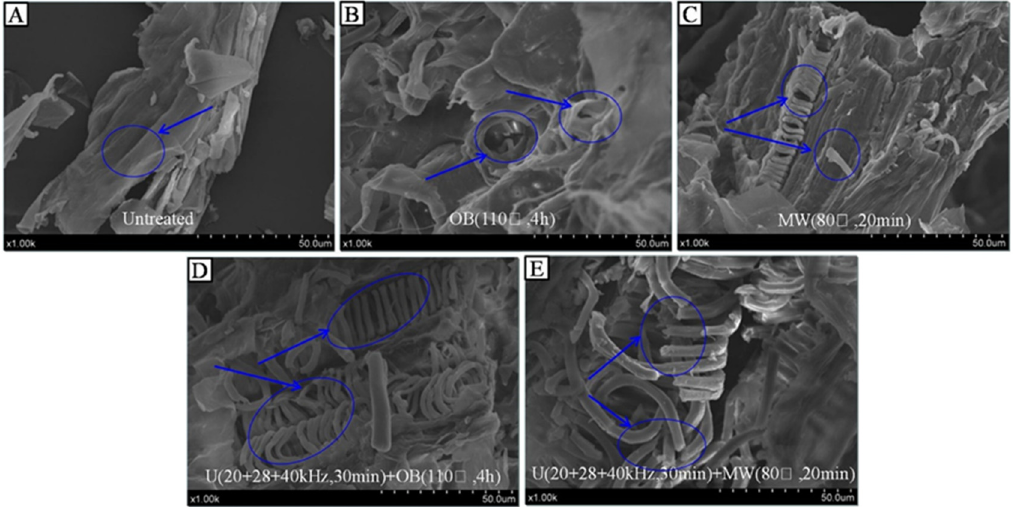
Figure 12. SEM images of GS under different pretreatment methods in TDES (ChCl-Gly-Al). Reprinted from Ind. Crops and Prod. , 149, 112357, Copyright (2020), with permission from Elsevier.